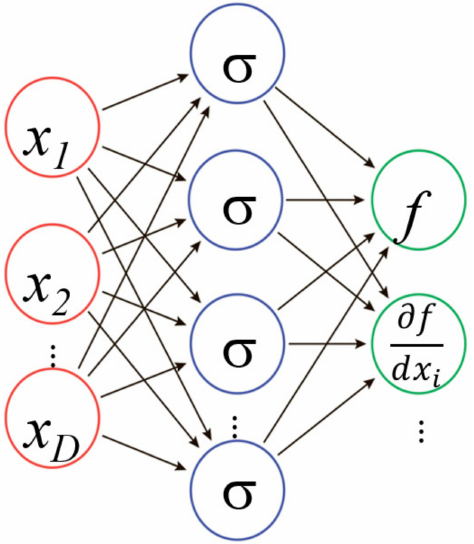
Figure 3. Schematic representation of a single-hidden layer neural